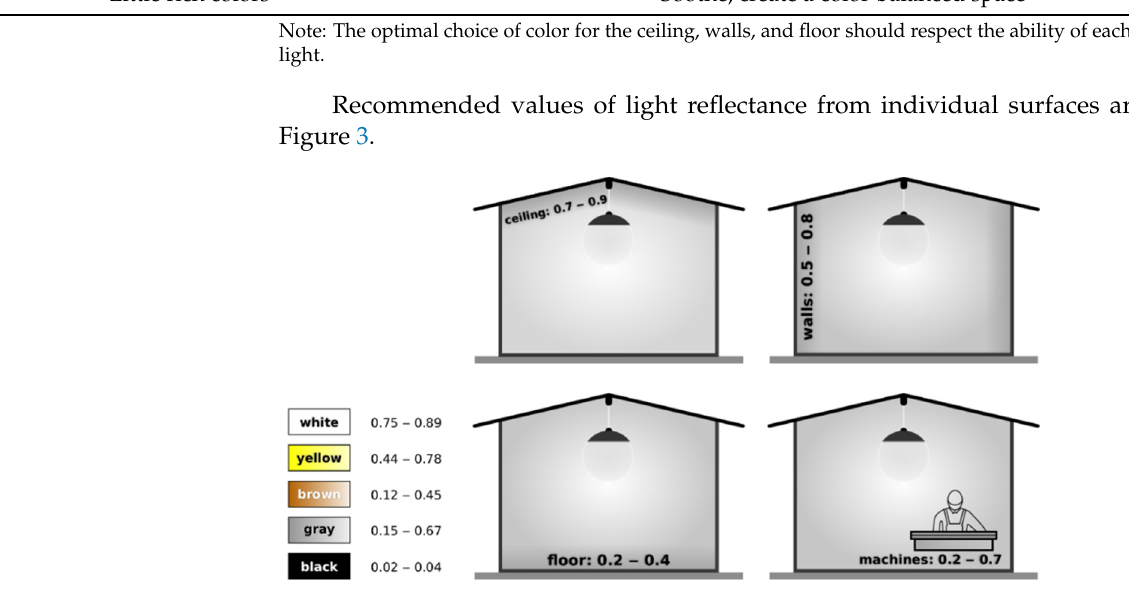
Figure 3. Reflectivity of interior surfaces. The study ends with an analysis of computer simulations of several design variants. RADIANCE software was used for daylight simulations. The effects of surface color on daylight were simulated for the actual surface color, which was measured in the hall, and for 14 surface colors. Simulations were based on a cloudy